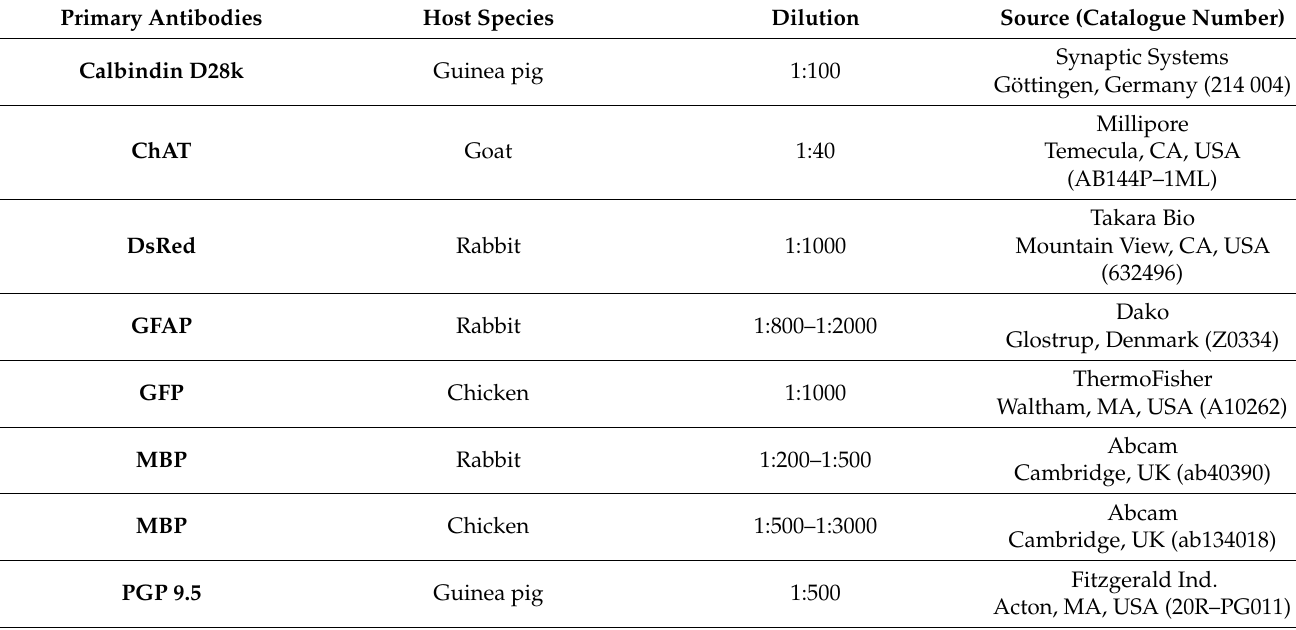
Table 4. Characterization of antibodies and toxins used for immunohistochemical staining. Primary Antibodies Host